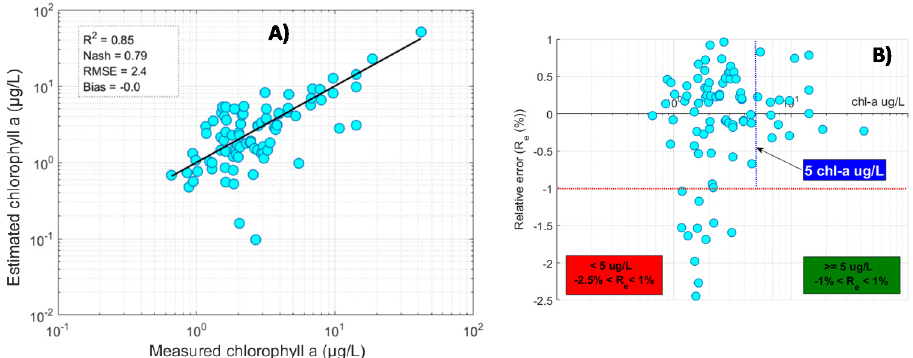
Figure 17. Assessment of the ensemble-based system: ( A ) with independent databases without turbid samples and ( B ) relative error results. X-axis and y-axis of the plot A and x-axis of the plot B are at a log scale.